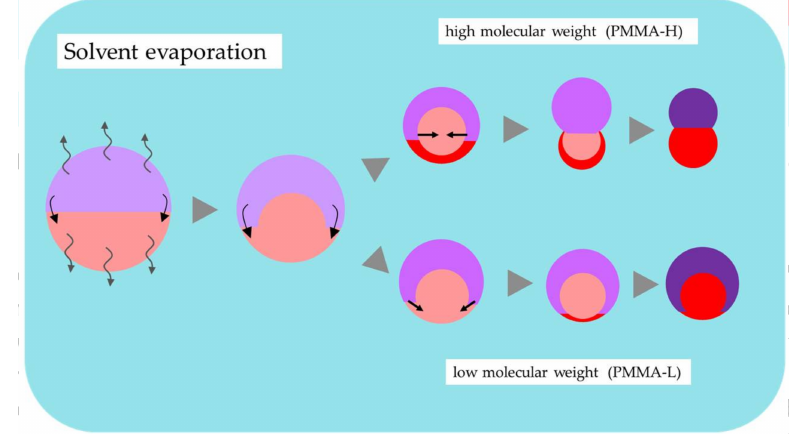
Figure 6. Illustration of the effect of molecular weight of PMMA in the formation of PBTPA/PMMA composite